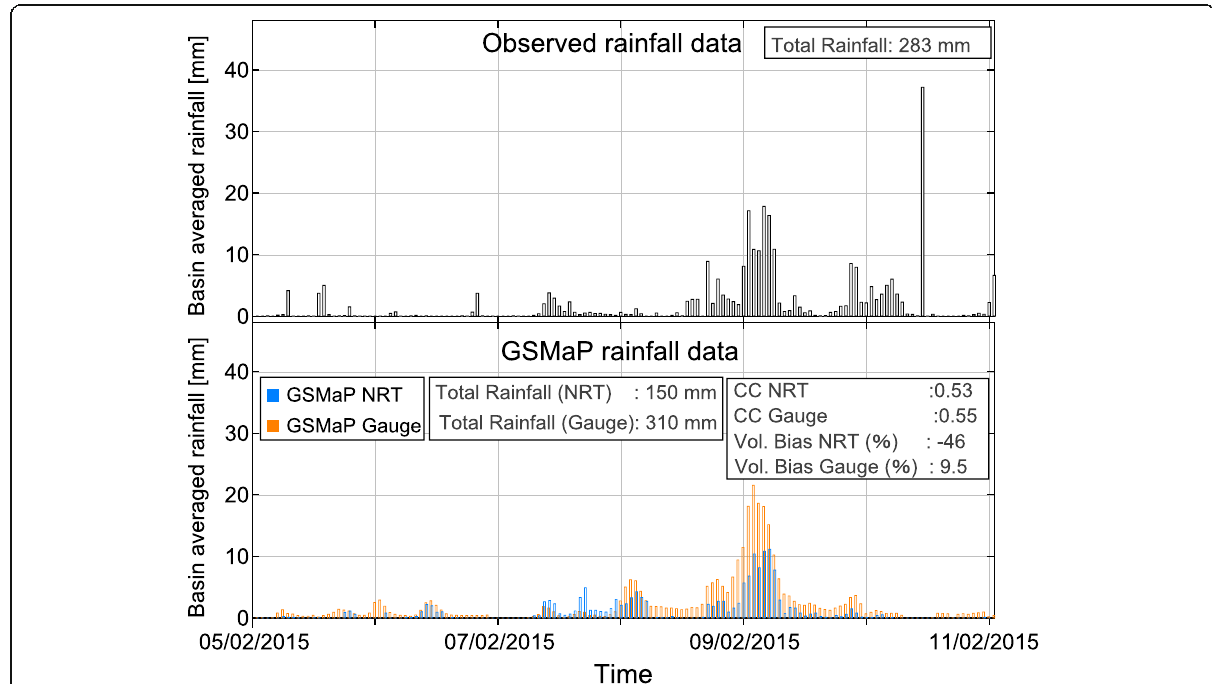
Fig. 2 Comparisons of hourly rainfall between GSMaP products (NRT & Gauge V7) and observation for flood event of 2015